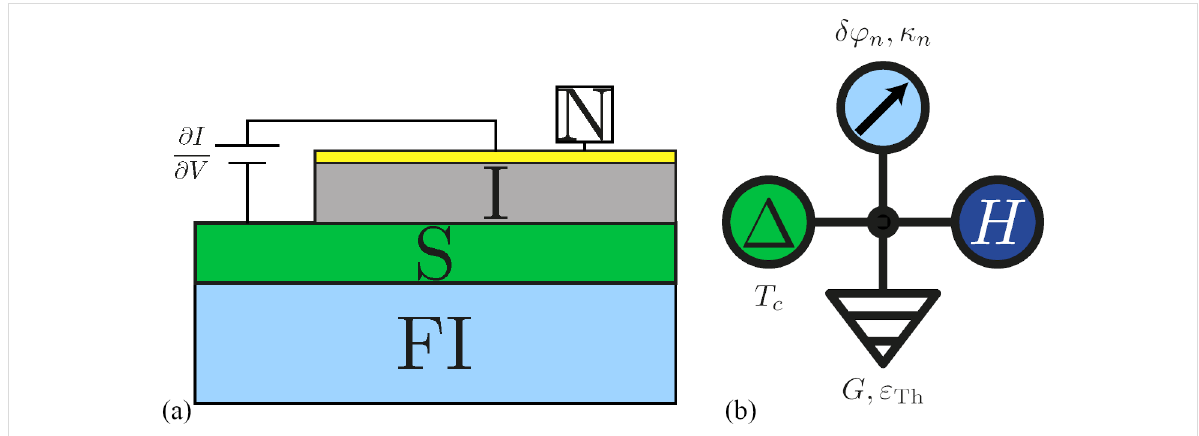
Figure 1: (a) The experimental setup of the FI–S bilayer. The differential conductance is measured with help of the top normal contact (N), which is separated by an insulating barrier (I). (b) Circuit diagram to represent the FI–S bilayer in the quantum circuit theory. The superconductor is repre- sented by the node, the Δ -source term, the ε Th -leakage term, and its normal-state conductance G . The ferromagnetic insulator adds the δφ n -term with magnetization directions κ n for each channel, and in accordance with the experiment an external exchange field is added, here represented by the H -pseudo